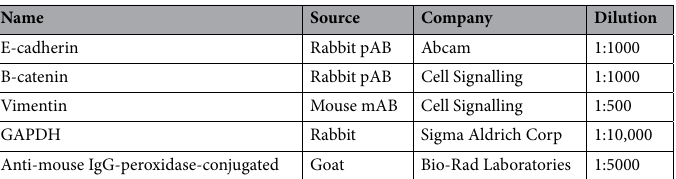
Table 1. Antibodies used in this study to evaluate protein expression by western blot. GAPDH glyceraldehyde 3-phosphate dehydrogenase, IgG immunoglobulin G.